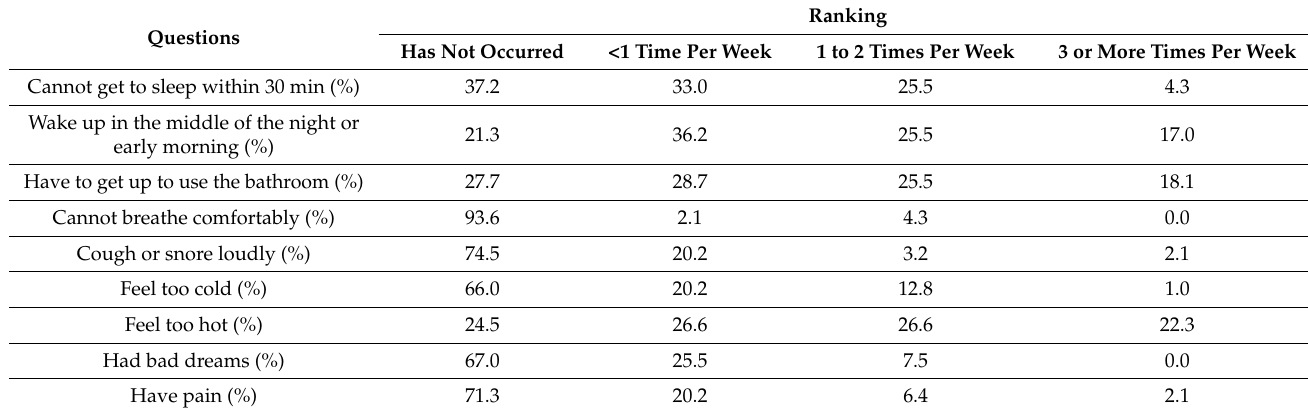
Table 4. Detail of responses to question 5 of the PSQI